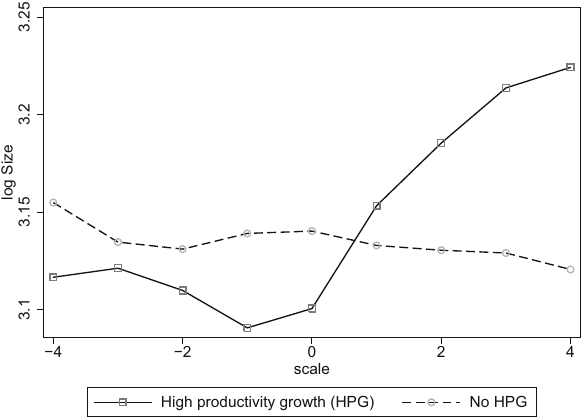
Fig. 2 TFP shock at s = 0 and subsequent size growth. Notes HPG firms are those with TFP growth above 10% in 2003, labeled as s = 0. The remaining firms are labeled as “No HPG” in the same year. The vertical axis plots average log size for these two different groups before and after